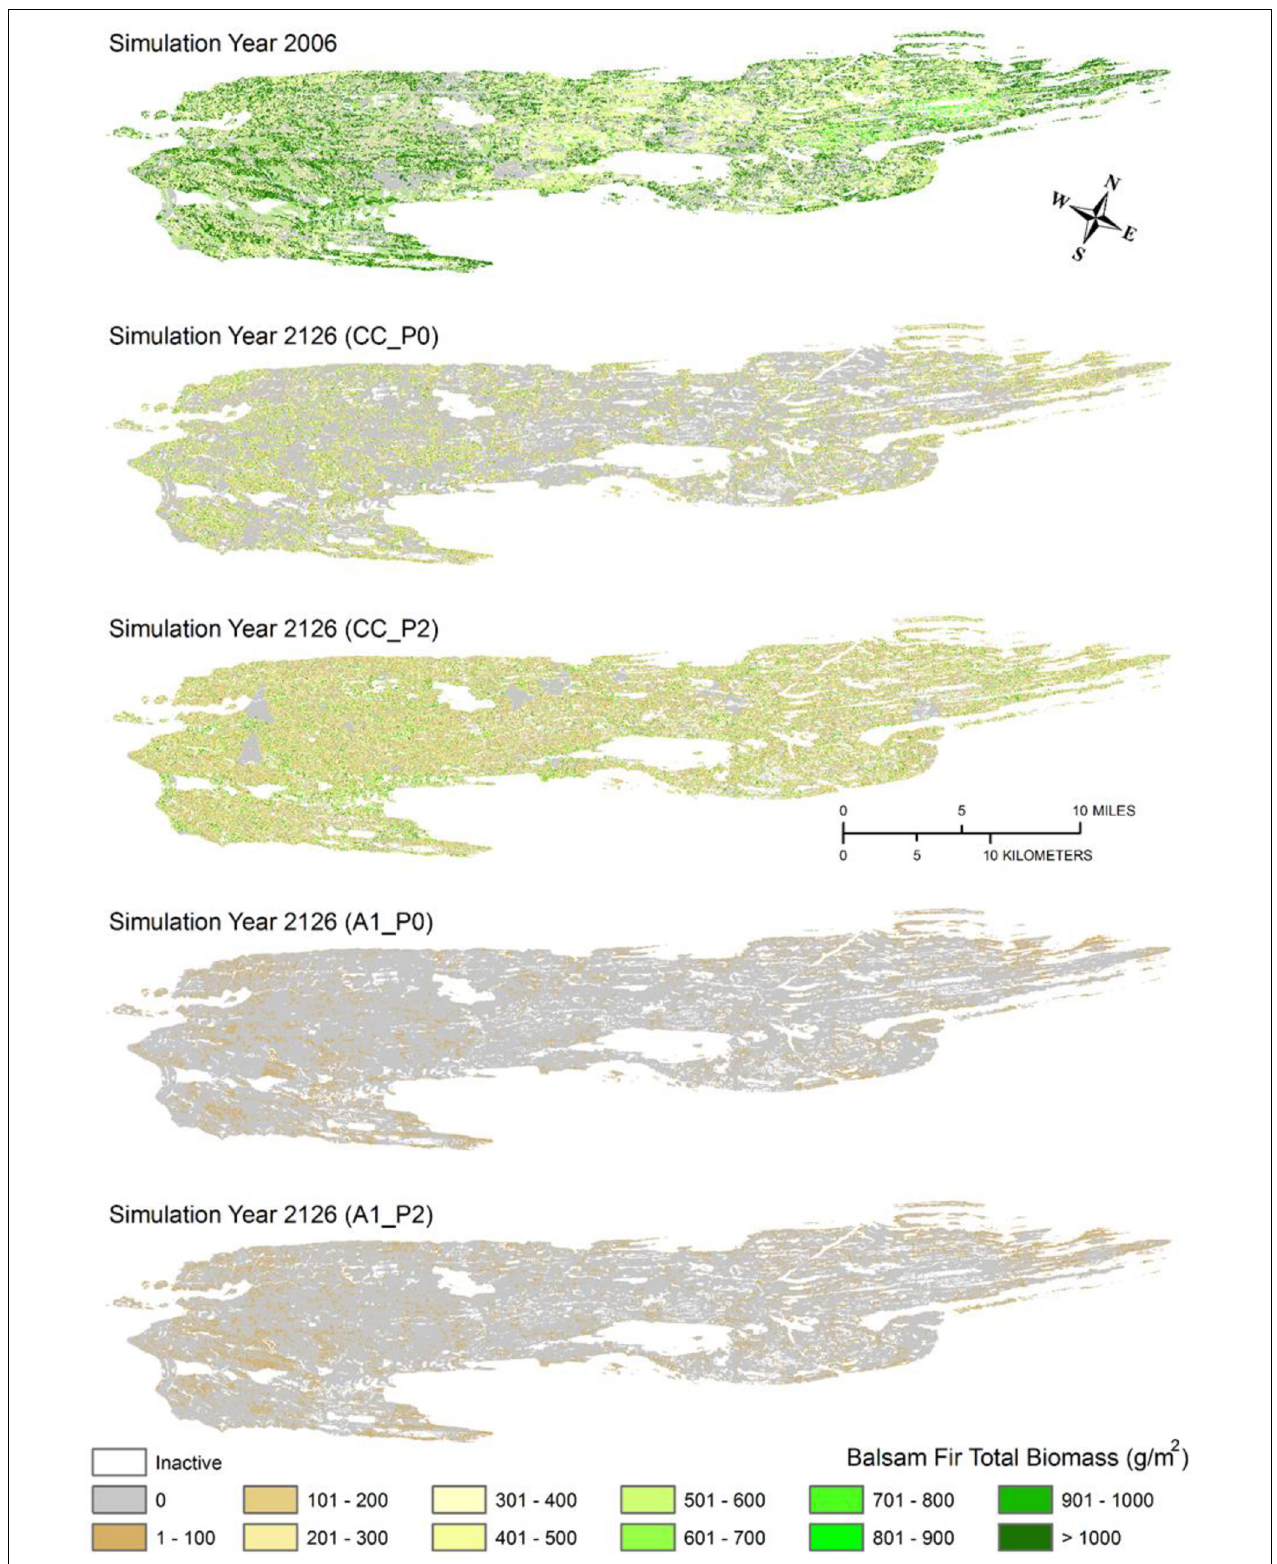
FIGURE 6 | Mapped distributions of balsam fir biomass for initial model conditions (simulation year 2006) and after 120 years of current climate and no predation (CC_P0), current climate and strong predation (CC_P2), high emissions and no predation (A1FI_P0), and high emissions and strong predation (A1FI_P2).